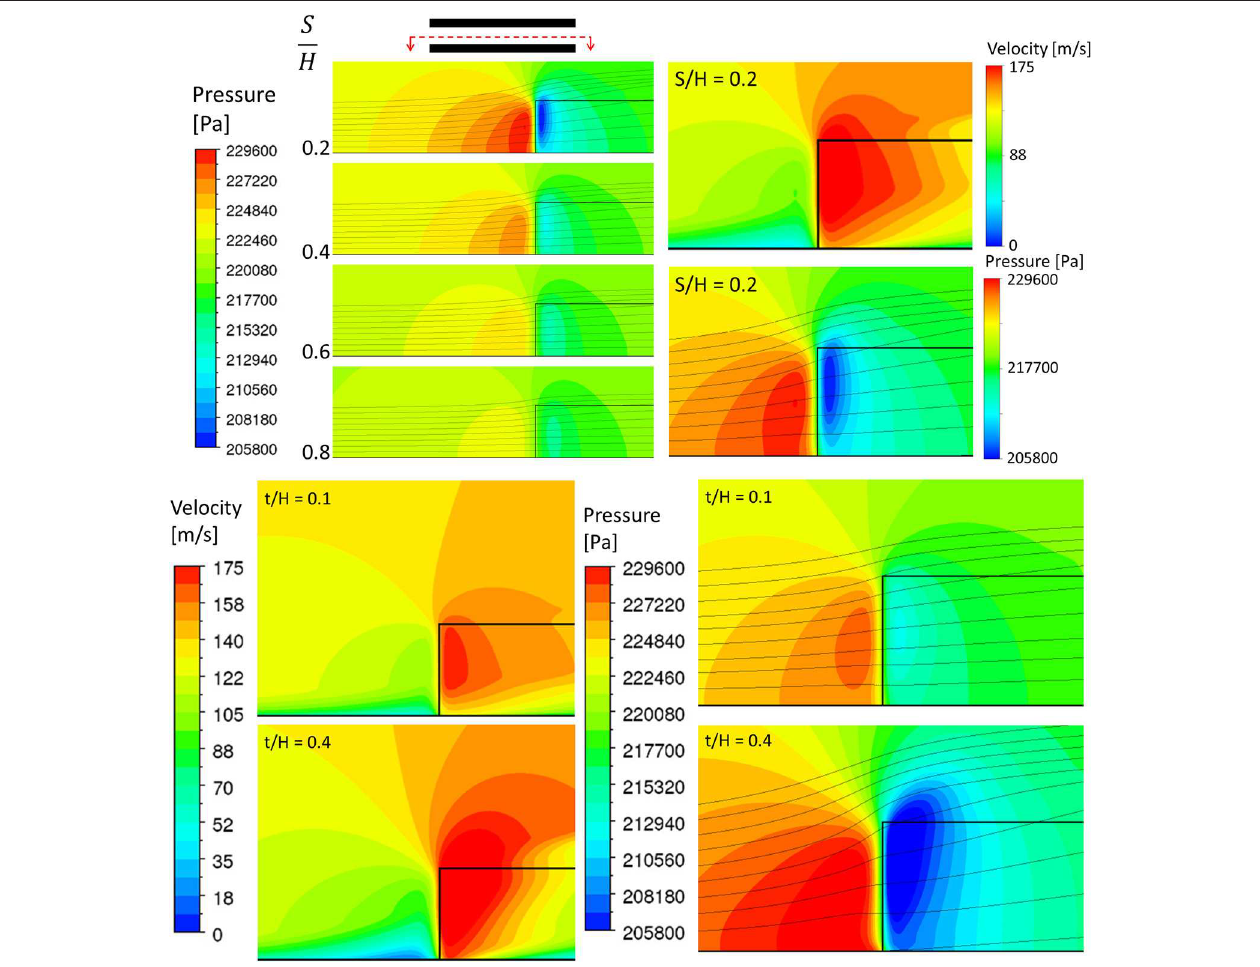
FIGURE 9 | Effects of S/H and t/H on pressure and velocity magnitude with streamlines near fin’s leading edge (Case 4, 7–9).